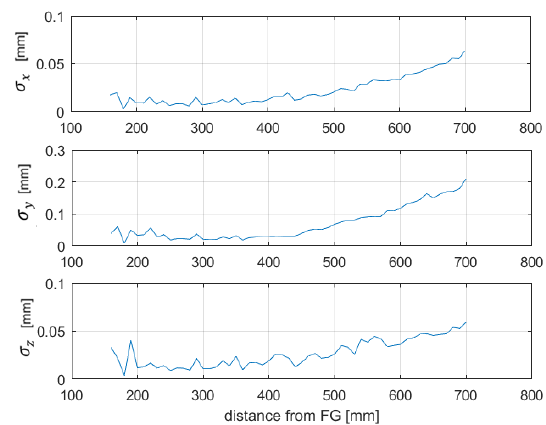
Figure 8. Position repeatability obtained with the estimation through gradients. Figure 7. Elements of the